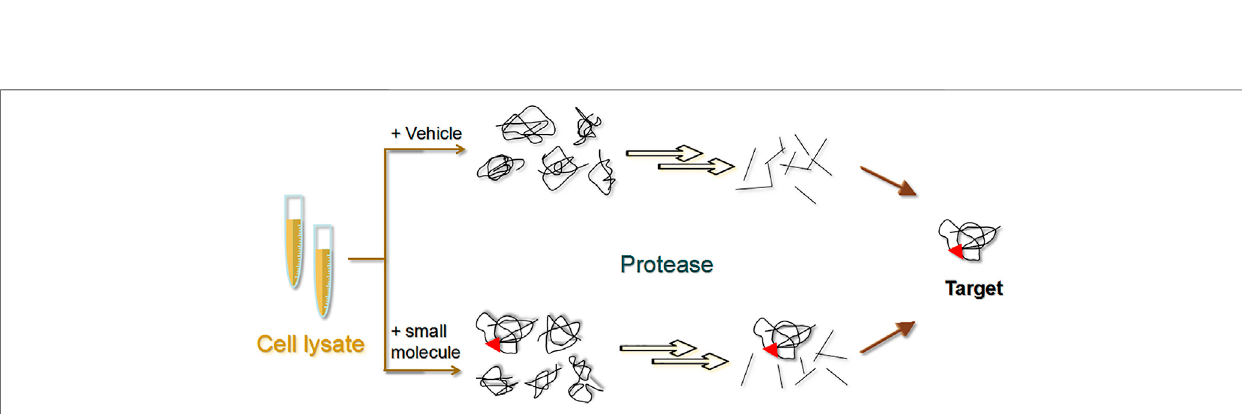
FIGURE8 | Schematic diagram ofthedrug af fi nity responsive target stability (DARTS) strategy. The experiment ismainly divided intoasmallmolecule group and a control group. Target proteins bound to small molecules are not readily hydrolysed by proteases.